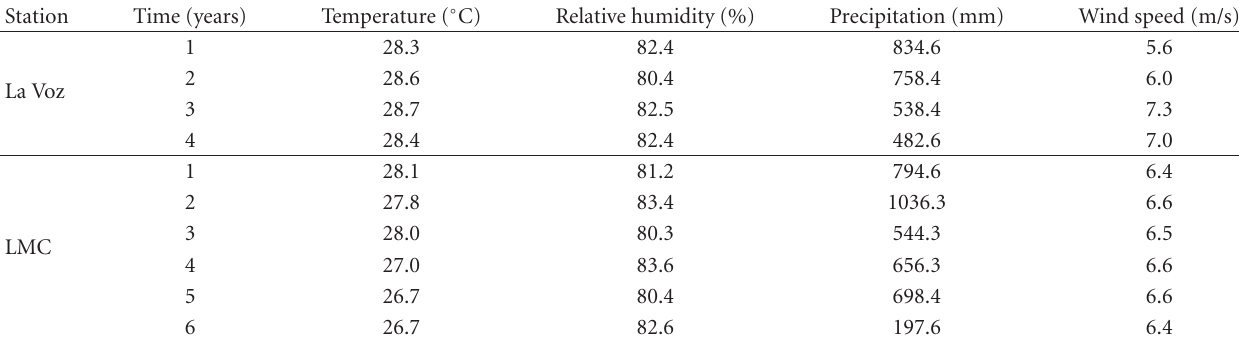
Table 2: Meteorological data during four and six years of exposure in La Voz Station and Lake Maracaibo Crossing Station (LMC), respectively.